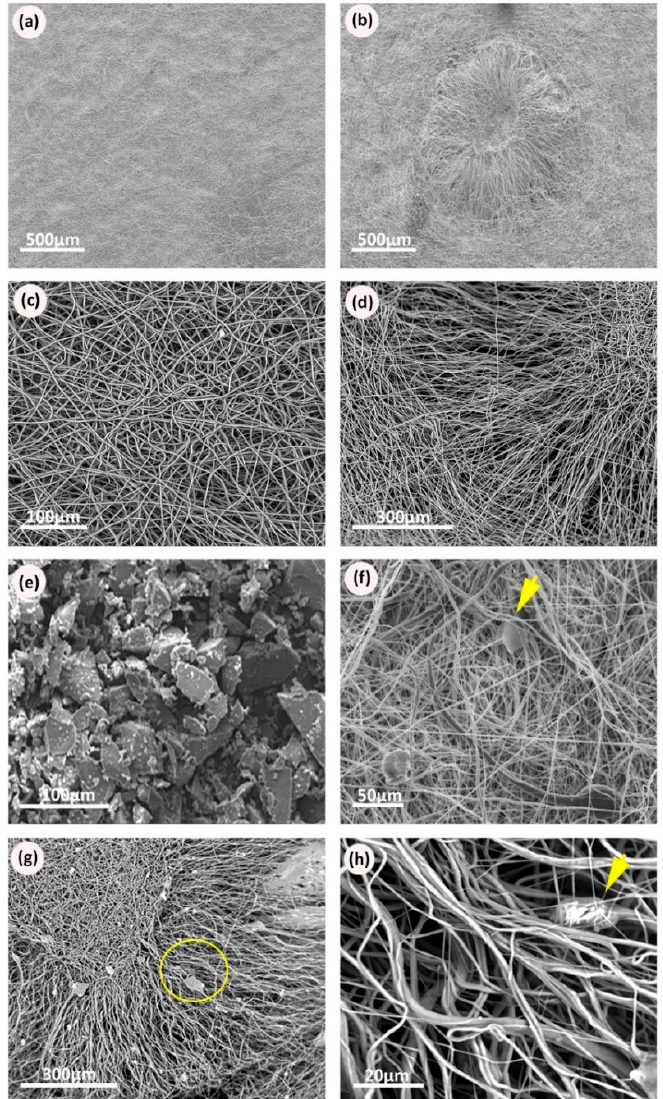
Figure 3. Scanning electron micrographs of the electrospun scaffolds: ( a ) Scanning electron microscopy (SEM) of Polycaprolactone (PCL) electrospun mesh, plain sample; ( b ) SEM of PCL electrospun niche sample showing the complete niche structure with the surrounding plain area between niches; ( c ) PCL electrospun fibers randomly distributed in a plain scaffold; ( d ) SEM picture showing the different patterns of fiber distribution within the niche structure; ( e ) SEM micrographs of BG powder, showing milled BG particles with irregular coarse surfaces and variable particle sizes within the same sample; ( f ) electrospun plain sample with BG, arrow points at BG particles appear within the structure of the randomly oriented fibers; ( g ) electrospun niche samples with BG, circle shows the edge of the niche; ( h ) higher magnification of the electrospun niche samples of PCL with BG, arrow points at BG particles appear within the structure of the aligned fibers.